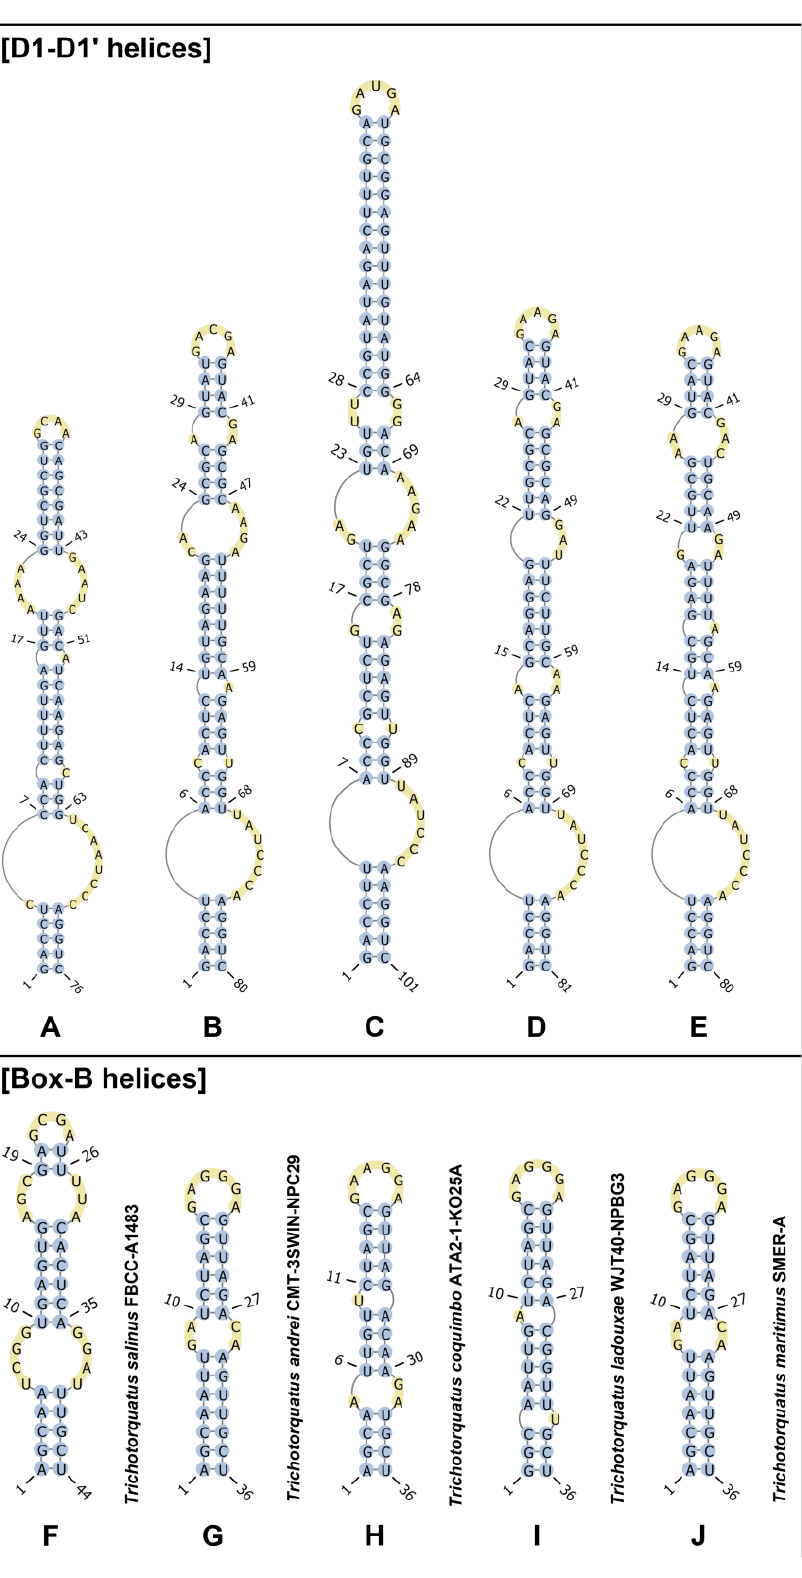
Figure 6. Secondary structures for the D1–D1 (cid:48) and Box-B (type 2 operon) in the conserved re- gions of the 16S–23S internal transcribed spacer region. ( A , F ) Trichotorquatus salinus FBCC-A1483; ( B , G ) T . andrei CMT-3SWIN-NPC29; ( C , H ) T . coquimbo ATA2-1-KO25A; ( D , I ) T . ladouxae WJT40- NPBG3; ( E , J ) T . maritimus SMER-A. These structures were drawn considering Pietrasiak et al.